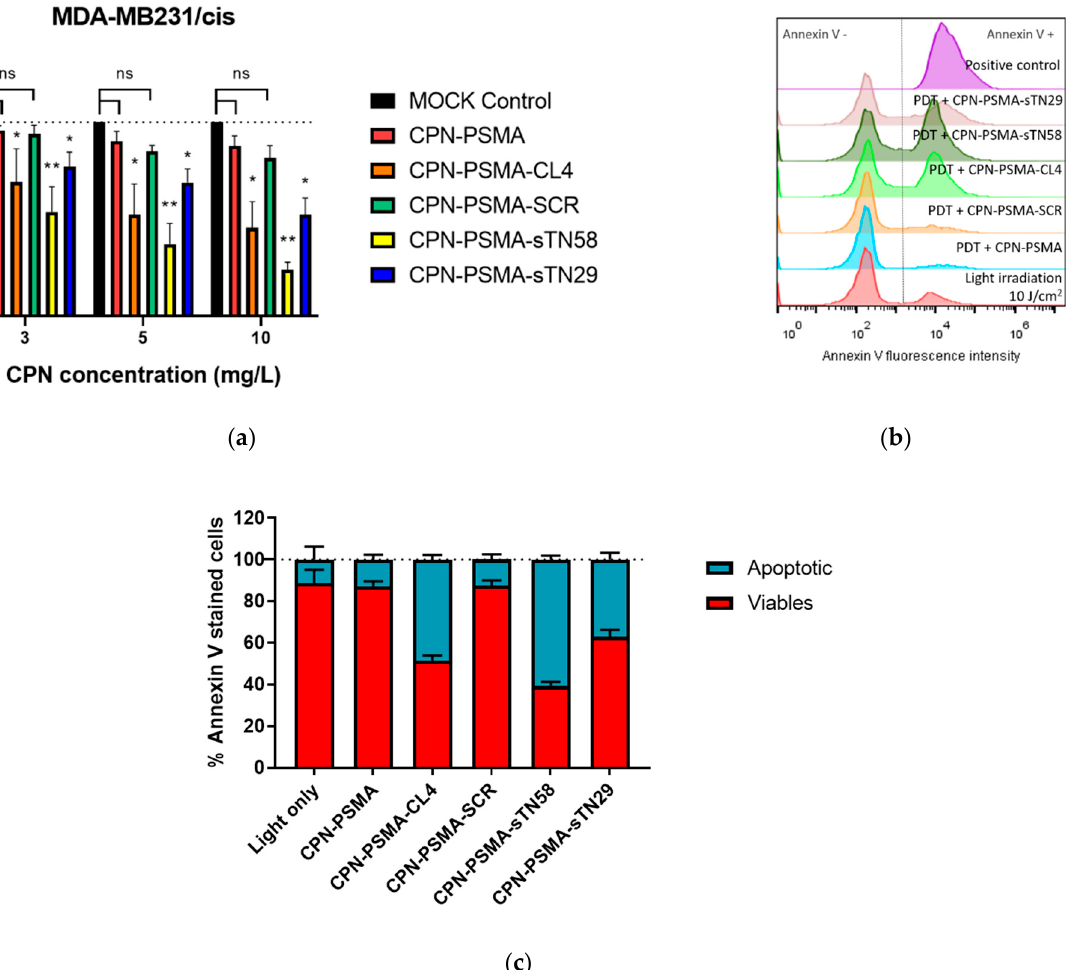
Figure 8. Photodynamic evaluation of aptamer-decorated CPN-PSMA in TNBC cells. ( a ) Cell via- bility (evaluated by MTT) after 24 h PDT treatment of MDA-MB-231/cis cell exposed to increased concentration of aptamer-decorated CPNs for 30 min and irradiated with blue light (10 J/cm 2 ). ( b ) Representative flow cytometry histograms corresponding to apoptosis analysis after PDT treatment (annexin V staining) with aptamer-decorated CPN-PSMA after 6 h post PDT (CPN concentration of 5 mg/L for 30 min and a light dose of 10 J/cm 2 ). ( c ) Bar graph of percentages of viable and apoptotic cells obtained from experiments described in ( b ). * p-value < 0.01 and ** p-value < 0.001 with ANOVA test, ns: no statistically significant differences.